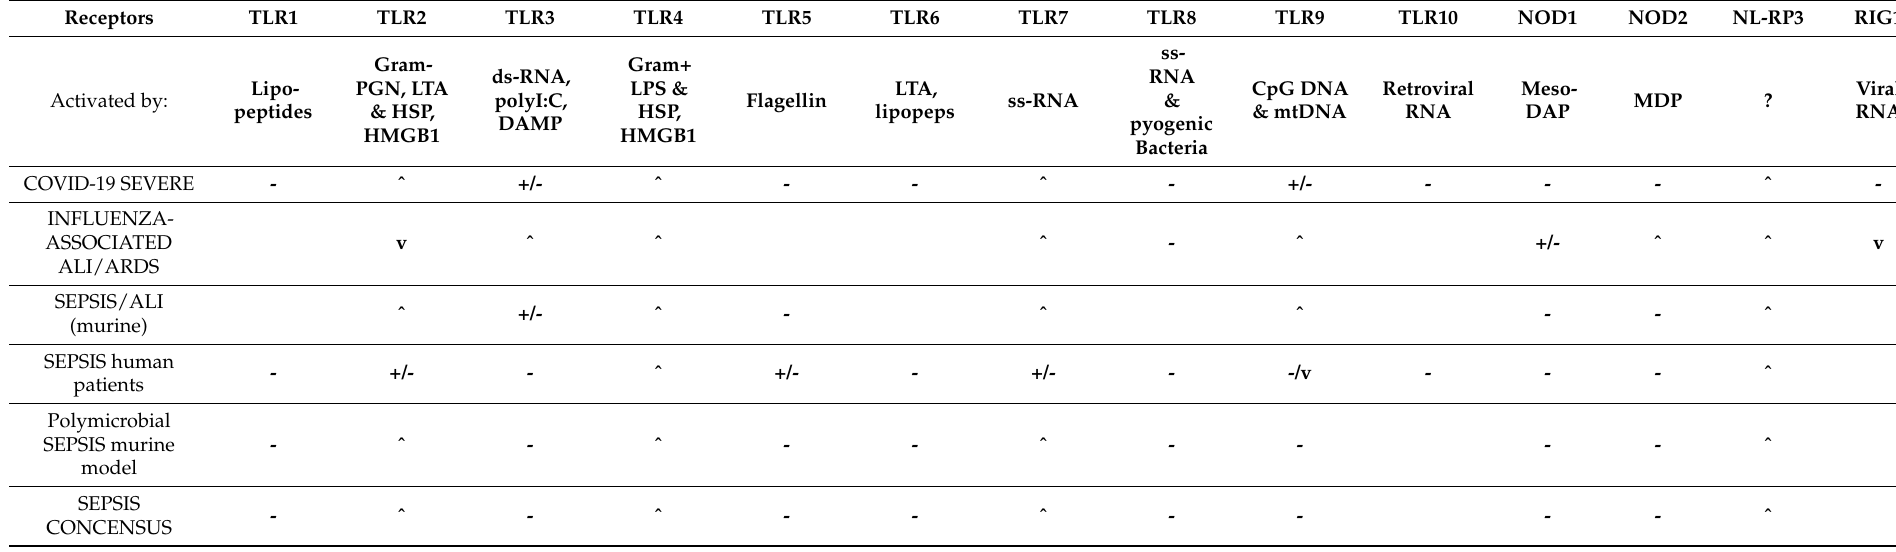
Table 1. Summary of studies quantifying the increased activation or protein expression of TLR and NLR for various syndromes associated with cytokine storms. Blank squares indicate that no data were found regarding the activity or expression pattern of the receptor. – indicates no change, ˆ indicates increased activation or protein expression, V indicates downregulation or decreased protein expression, +/ − indicates conflicting reports about whether there is increased activity or protein expression and -/V indicates conflicting reports about whether there is no change or downregulation. ALI stands for acute lung injury; ARDS stands for acute respiratory distress syndrome; Gram- = expressed by Gram-negative bacteria; PGN = peptidoglycan; LTA = lymphotoxin alpha; HSP = heat shock protein; HMGB1 = High Mobility Group Box 1 protein; dsRNA = double-stranded ribonucleic acid; polyI:C = polymer composed